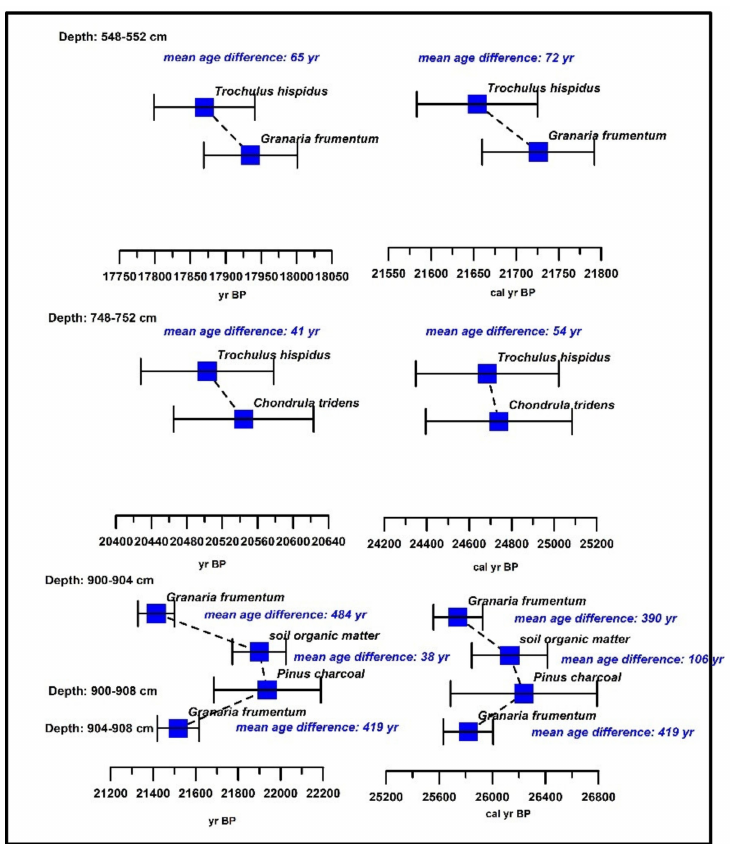
Figure 2. Comparison of conventional and calibrated ages of different mollusk taxa for samples at the same